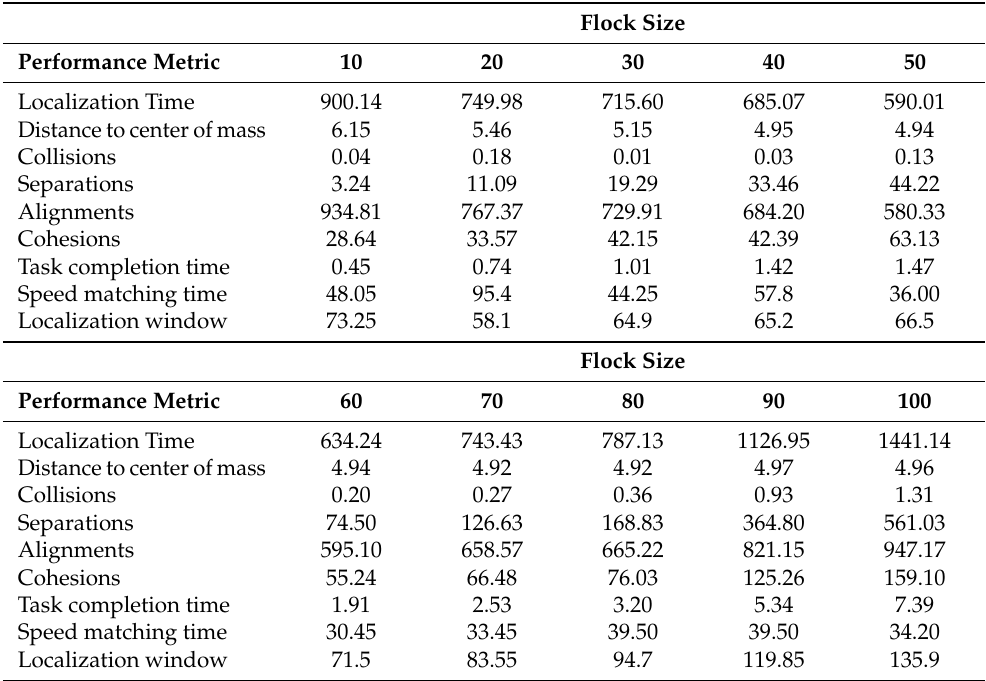
Table 4. Performance metric results averaged over twenty simulations for flock sizes in 10–100, in an environment with